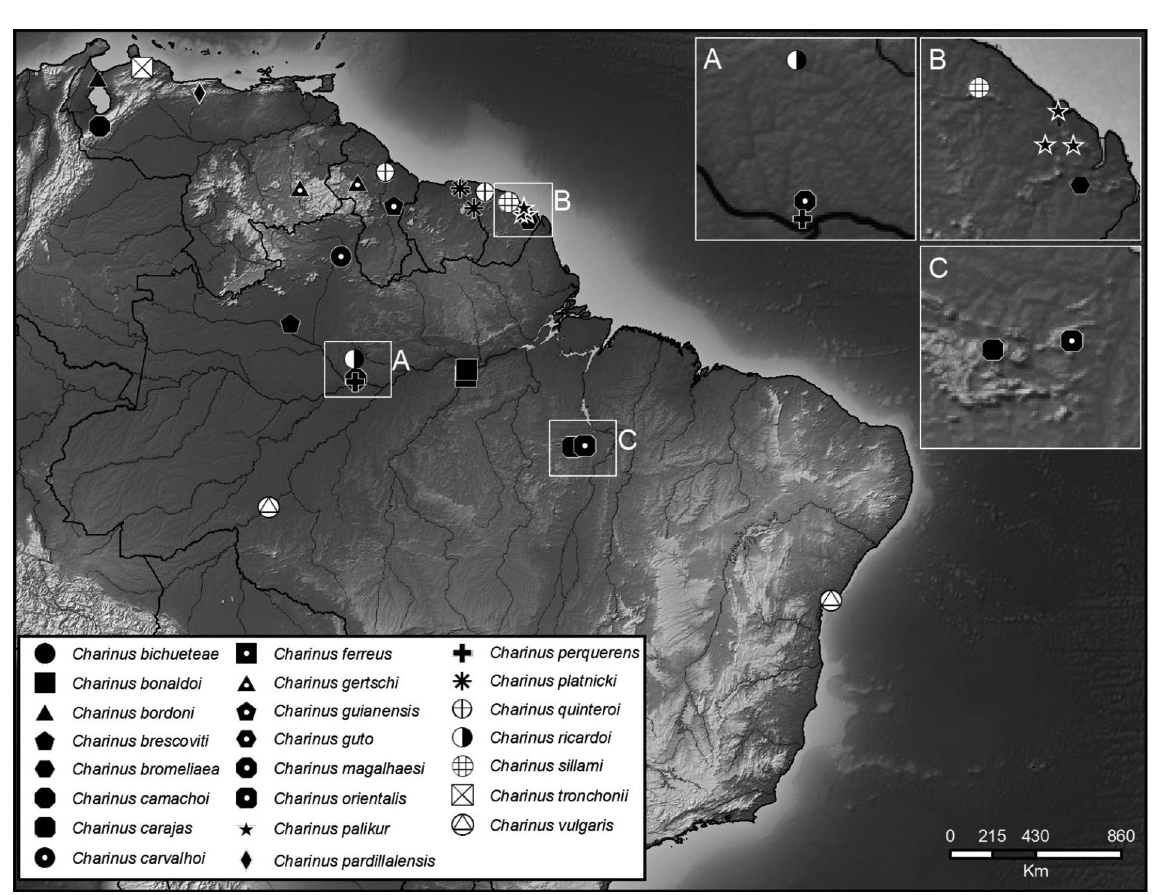
Fig. 27. Map plotting known distributions of species of Charinus Simon, 1892 in northern South